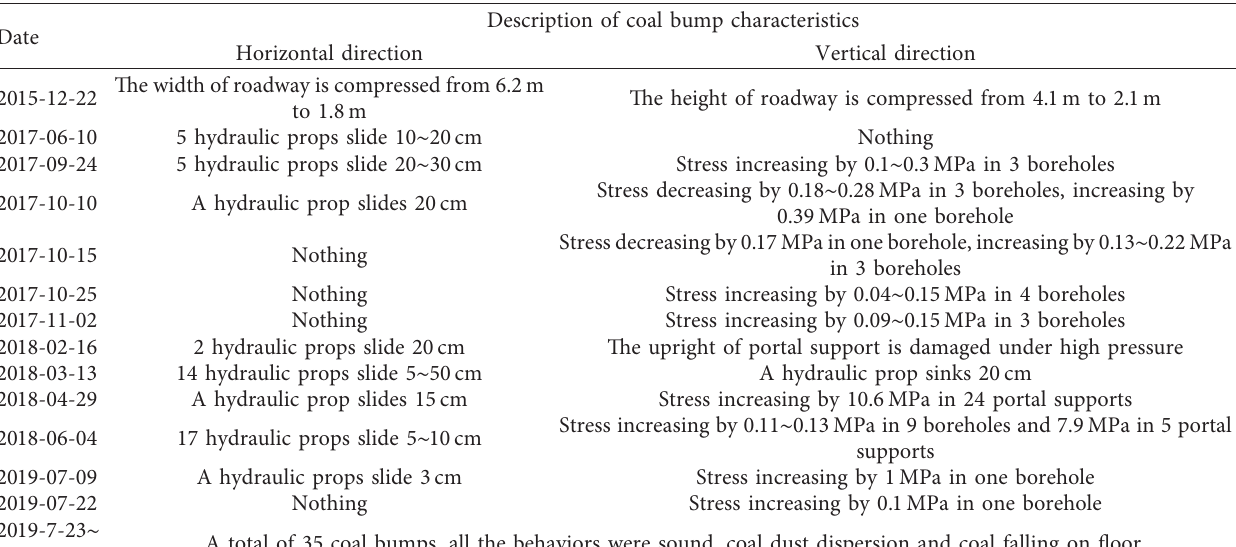
Table 1: The coal bump behavior in 13230’s mining